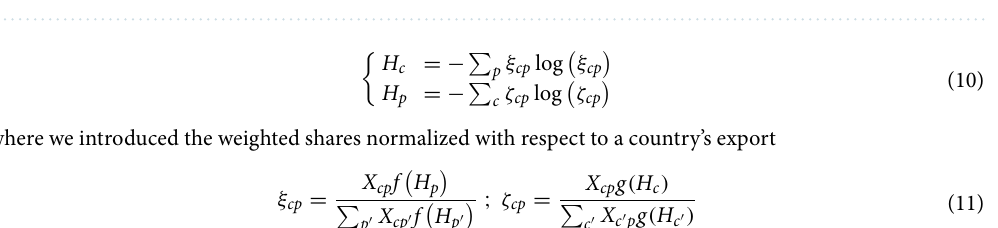
Figure 4. ( a ) Fixed point of the entropic measure H c for the countries vs. the overall export X c . The colors used are related to the number of exported products. We can see how the countries that belong to the “poverty trap” line ( N < 1000 ) introduced in Fig. 2b are here scattered over a wide area (highlighted in red). ( b ) Ubiquity of the products H p vs. World aggregated export of that same product. The color scale reflects the number of countries exporting such product. The black lines mark the medians of the ubiquity and of the amount of worldwide export. They allow us to classify products in 4 different main